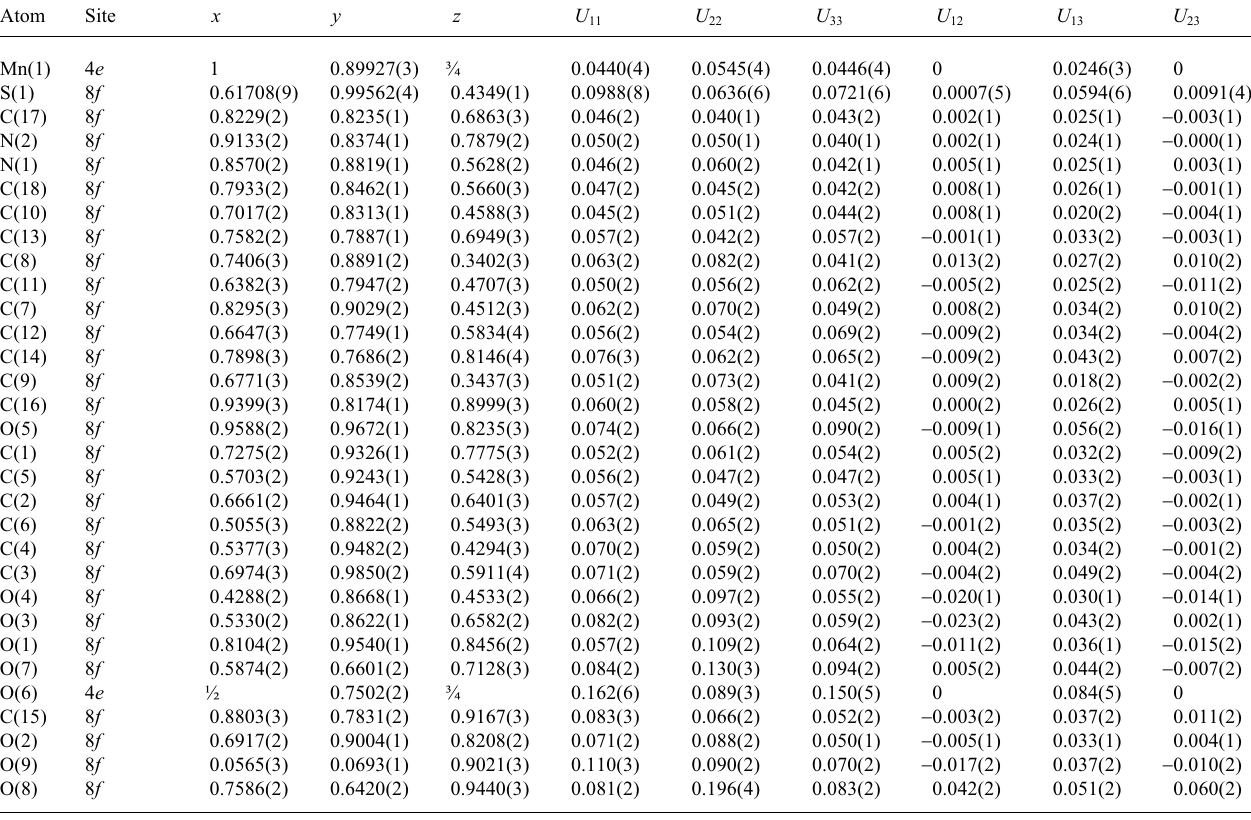
Table 3. Atomic coordinates and displacement parameters (in Å 2 )